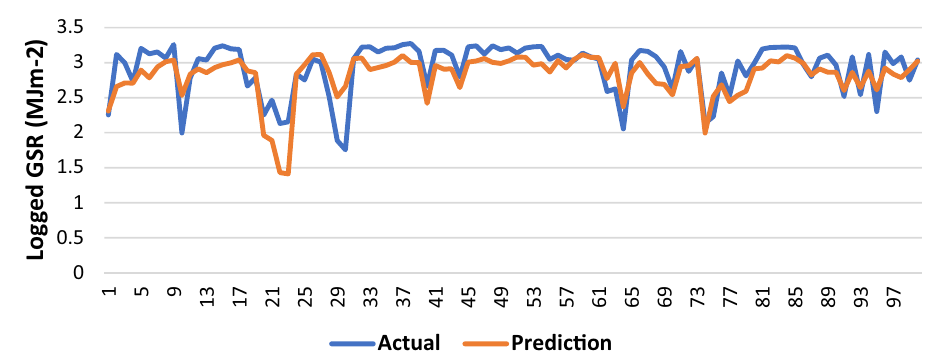
Figure 4. Graph of Actual and Predicted GSR (Model I—SCG).